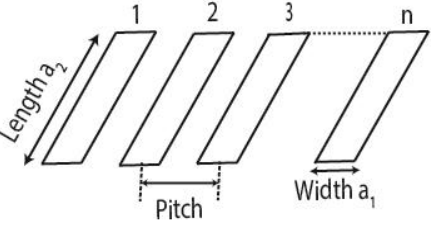
Figure 2. Elements of an array transducer.